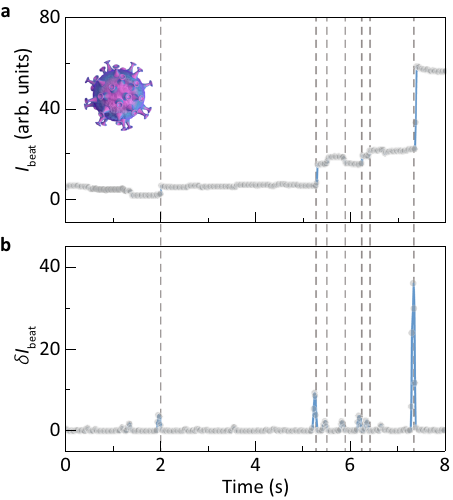
Fig. 4 Detection of single virus-like particles. a – b I beat ( a ) and the corresponding δ I beat ( b ) when HIV-1 virus-like particles are deposited at the joint sensing